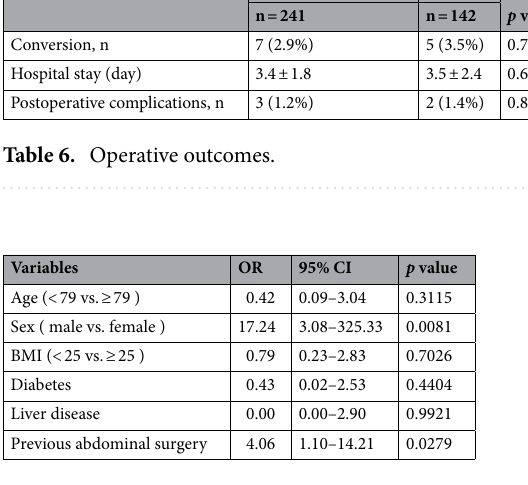
Table 7. Multivariate analysis of factors associated with conversions. OR, odds ratio; CI, confidence interval.